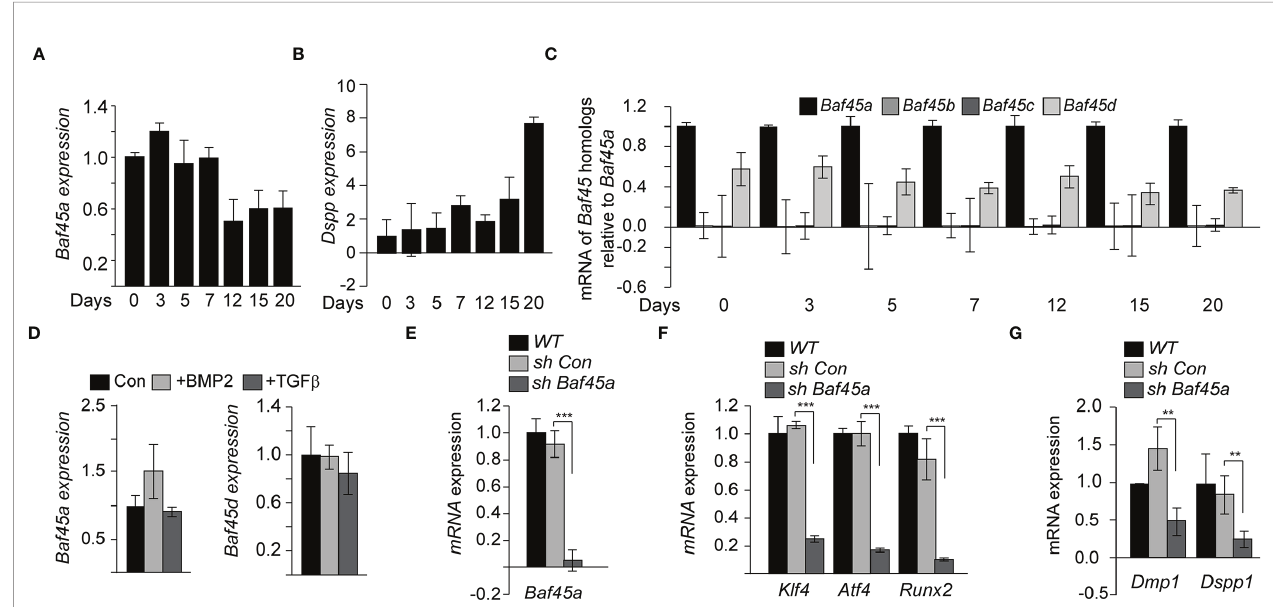
FIGURE 3 | Baf45a functions promote odontoblast differentiation. (A) Relative expression levels of Baf45a were obtained by real-time RT-qPCR using total RNA isolated from murine odontoblast OD-21 cells induced to differentiate for 20 days. b -Actin cDNA was used as a loading control. (B) Real-time RT-qPCR analysis for the relative expression levels of Dspp using total RNA isolated from murine odontoblast OD-21 cells differentiated for 20 days. (C) Representative of mRNA analysis in triplicate (n=3) of Baf45 homologs in OD-21 cells induced to differentiate for 20 days. (D) Baf45a and Baf45d responsiveness to BMP2 and TGF b in OD-21 odontoblast cells. RT-qPCR analysis from OD-21 cells treated with BMP2 (100 ng/ml) and TGF b (10 nM) at 80-90% con fl uence of culture and harvested 24 h post-treatment. (E) OD-21 cells were treated without shRNA (WT), control shRNA ( con sh ), and shRNA speci fi c to Baf45a ( sh Baf45a ). After 72 hrs. post-treatment, RT-qPCR was performed on the RNA isolated from the harvested cells to assay the expression of Baf45a . Gapdh expression was used to normalize the relative gene expression. (F) Effect of Baf45a shRNA was assayed on the expression of Atf4, Klf4, and Runx2. (G) odontoblast differentiation markers Dmp1 and Dspp1 were assayed. Gapdh expression was assessed to normalize the relative expression. Statistical signi fi cance was determined by Student ’ s t-test (*P ≤ 0.05; **P ≤ 0.01; ***P ≤ 0.001 versus matched